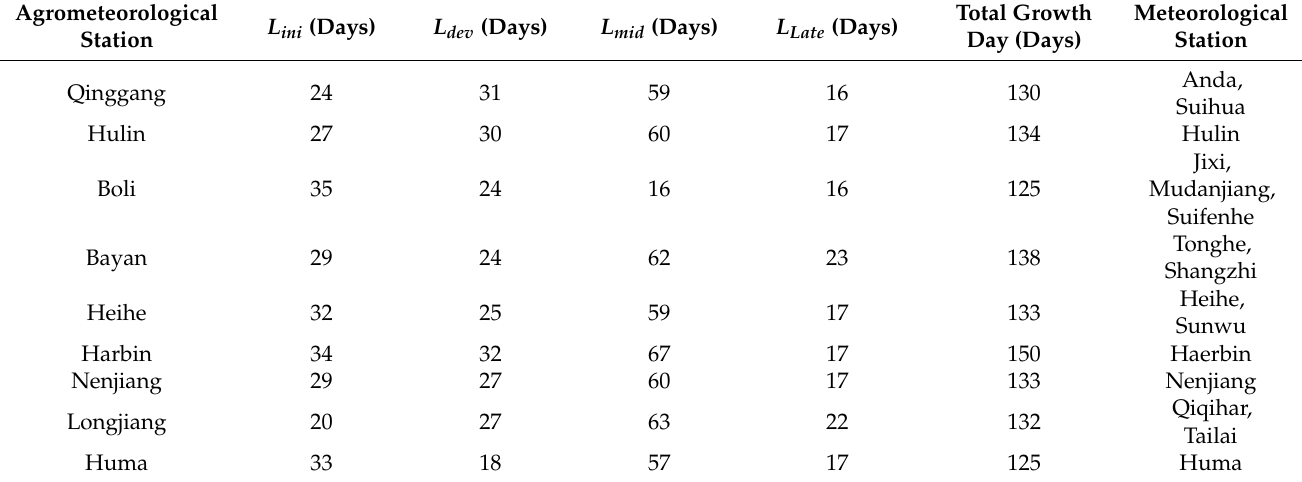
Table 1. Average soybean growth period data in 1994–2005.